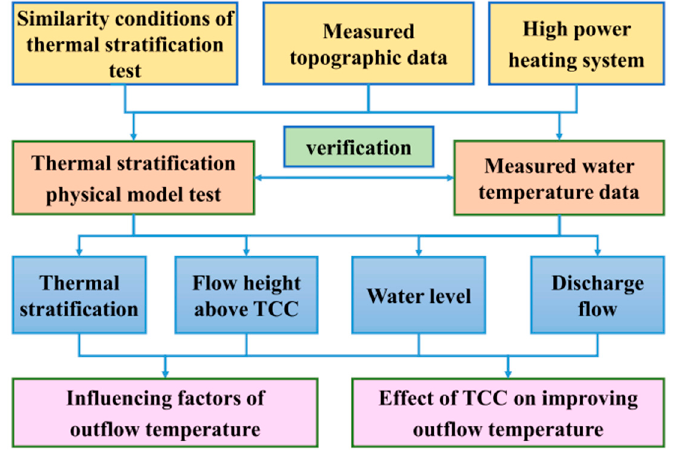
Figure 2. Working program.